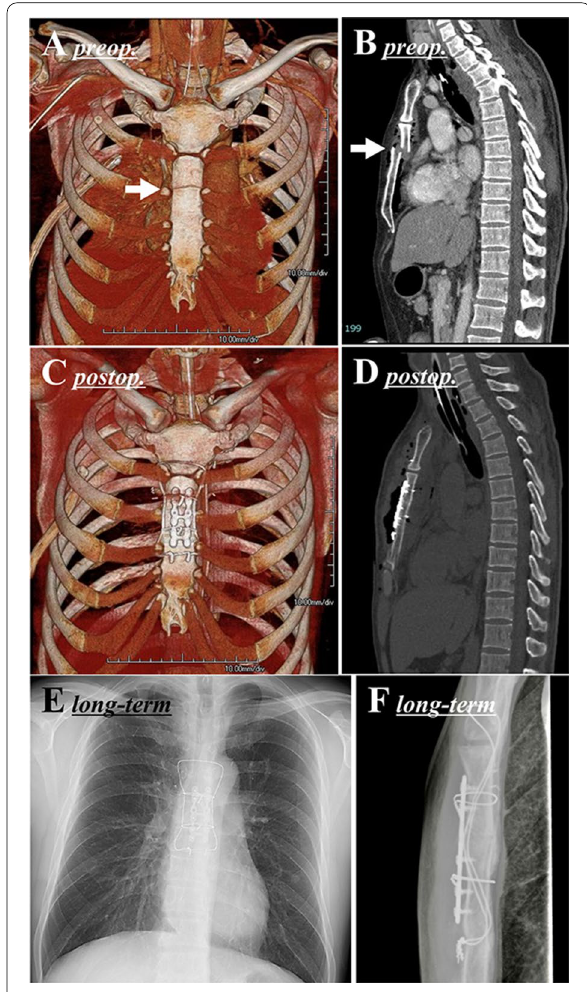
Fig. 1 Pre- and post-operative images in Case 1. Preoperative computed tomography ( A , B ) demonstrated a fracture line at the level of the 2nd lower intercostal margin (arrow) and the posterior displacement of the upper sternum. Postoperative computed tomography ( C , D ) and long-term radiograph ( E , F ) confirmed that the sternum was properly